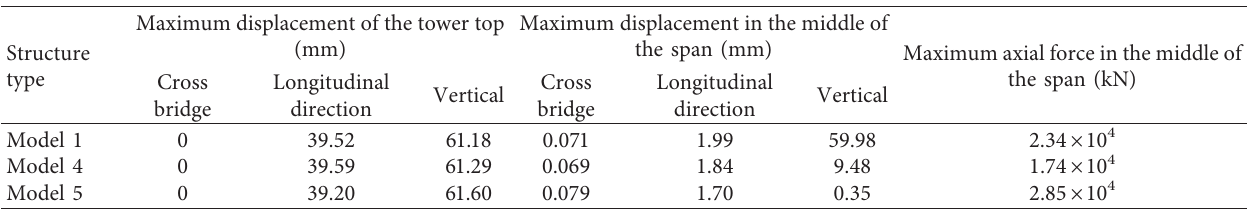
Table 13: Maximum bending moments of the tower roots and midspans of the three structural models under longitudinal bridge excitation. Structure